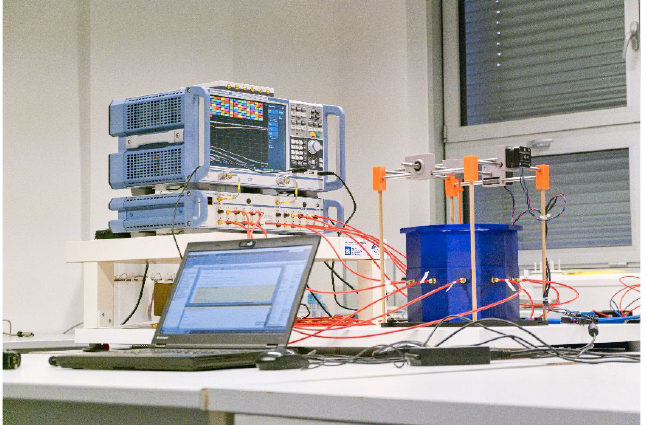
Figure 5. A laboratory prototype of the microwave imaging system [11] consisting of an in-house a vector network analyzer ZNB8, and a switching matrix ZN-Z84, both Rohde Schwartz, Germany.